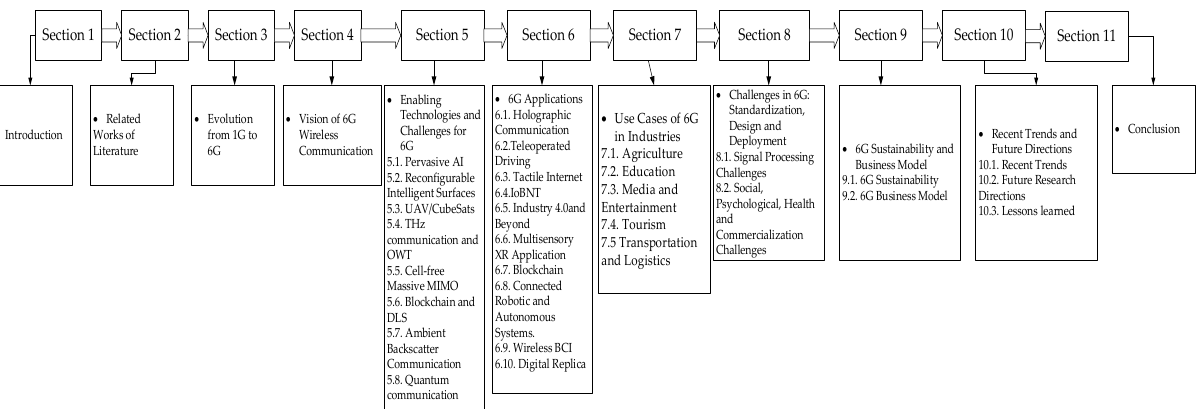
Figure 1. This is a figure showing the layout of the paper.